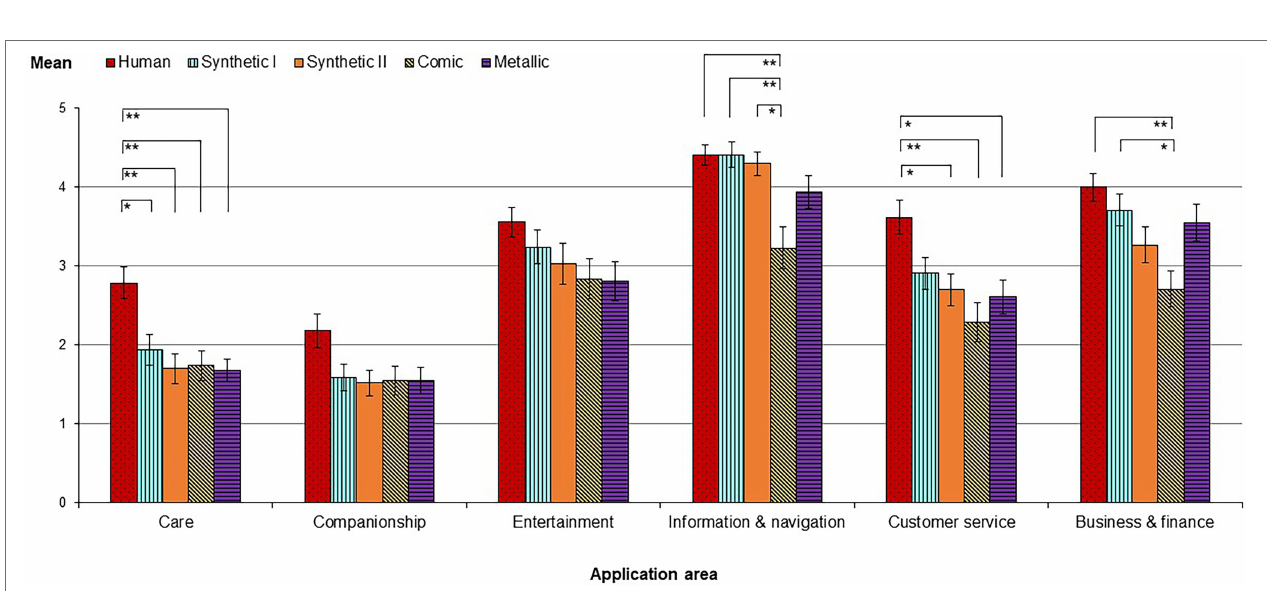
FIGURE 2 | The bar chart shows the absolute values as percentage of invented names depending on the heard voice. The names were assigned to one of the five name classes.